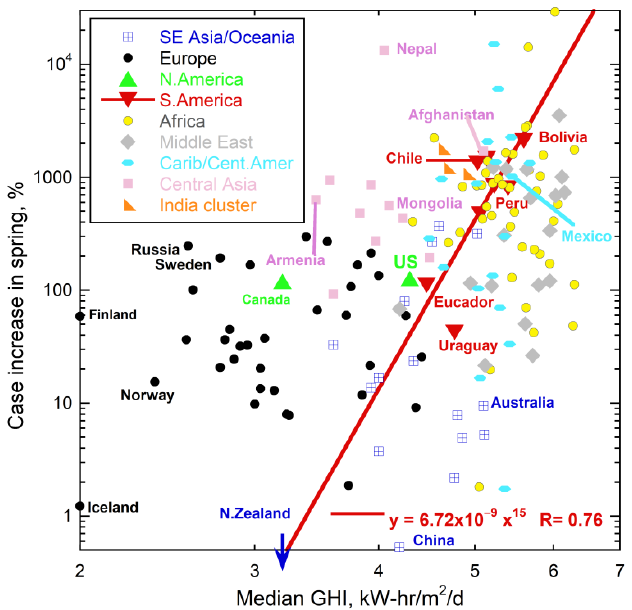
Figure 8. Increase in COVID-19 cases listed in [46,53] in the spring as a function of solar irradiance from the Global Solar Atlas website [89], averaged over the year. Countries grouped as in Figure 6. New Zealand cases decreased, as also occurred in France (not shown). A few counties with 1–3 cases were excluded to reduce noise. GHI was estimated for the northernmost countries, which include Canada and those near the left axis, with labels, by assuming their lowest measured GHI value was 2. Russia, Sweden, and Finland, which are the three countries nearest to Siberian permafrost, all have high case increases for their GHI values. Similarly, Canada which has substantial permafrost has a large number of cases given its irradiance. Unlike Figure 7, a per day basis was not used, and only the April-to-June increase is shown.